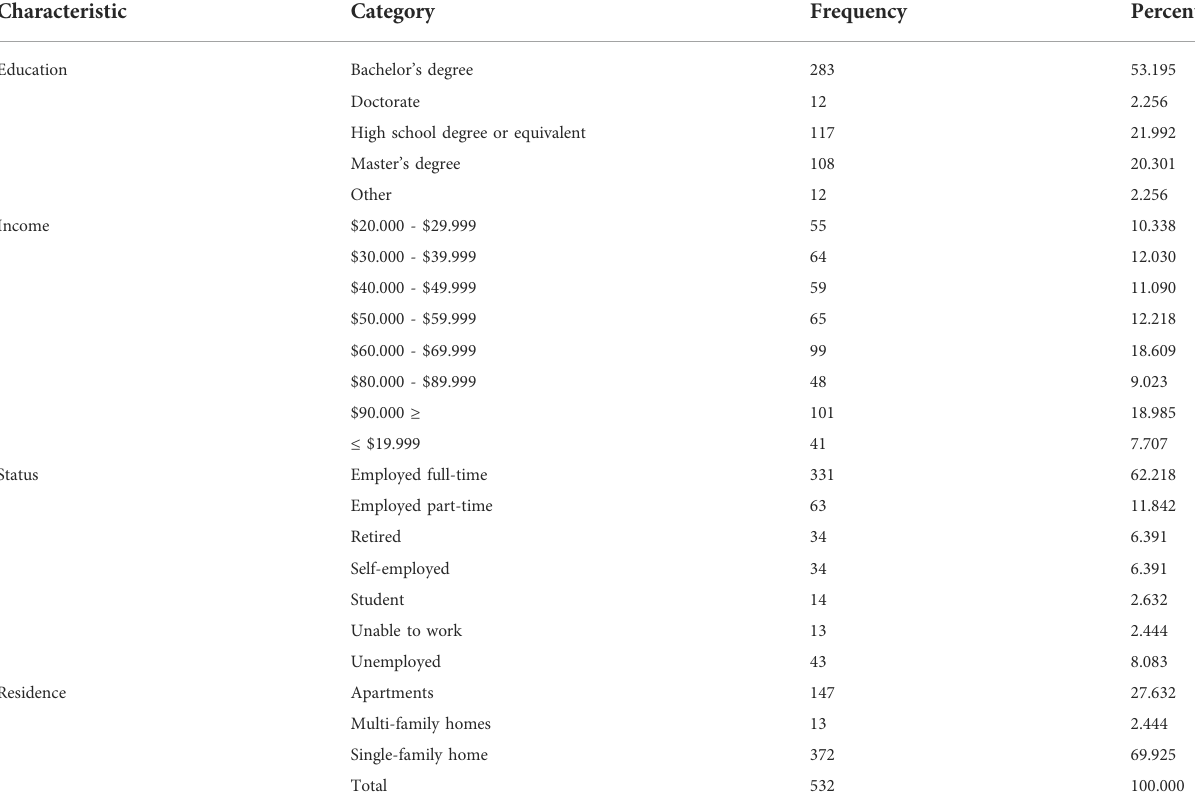
TABLE 1 Respondent